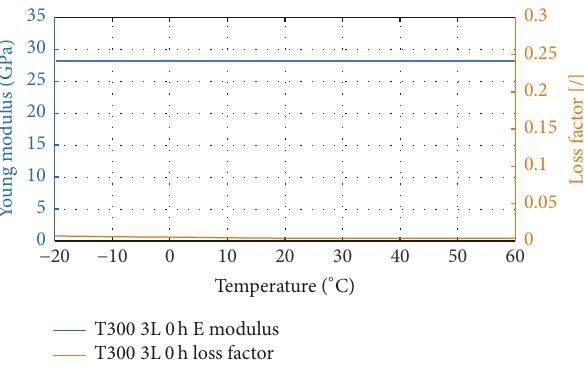
Figure 2: Material characteristics as a function of temperature: CFRP T300 material.